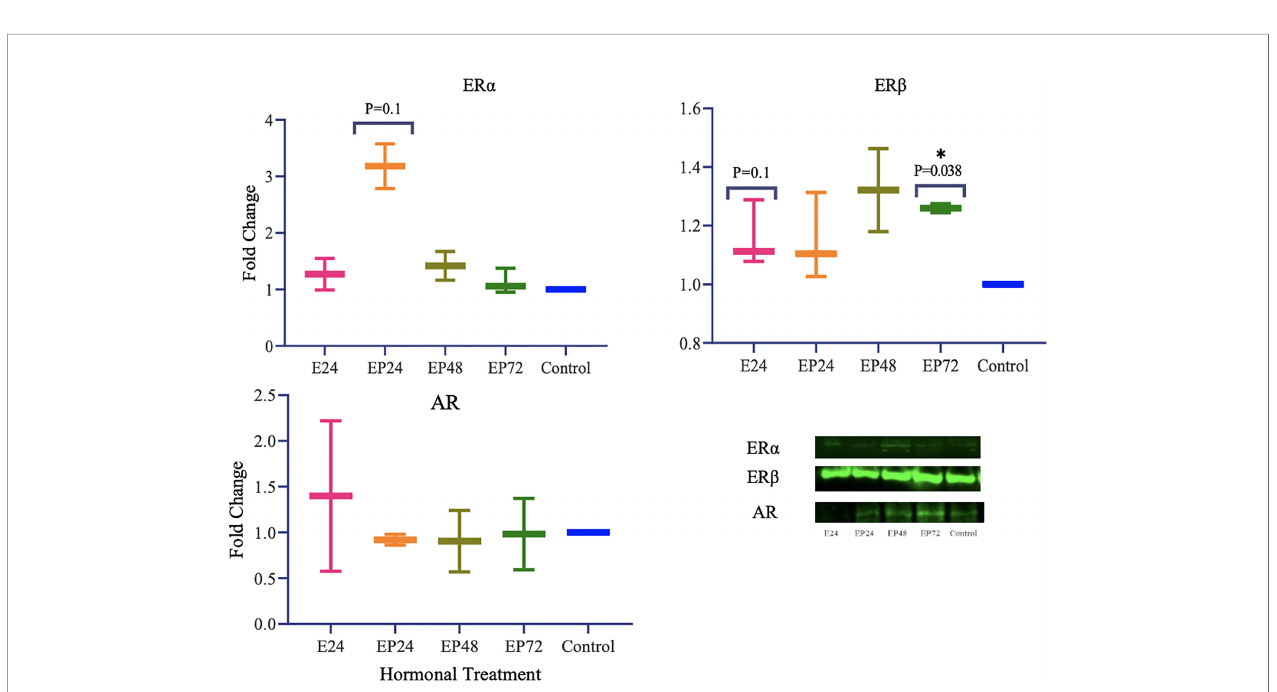
FIGURE 6 | Steroid hormone protein expression in response to different steroid hormone treatments in RL95-2 cells. A representative blot image for the particular weight band is shown next to the graph. The y-axis shows the fold change of protein levels following different treatments compared to control and x-axis shows the different treatment groups. E24 = 24h Estrogen; EP24, EP48 and EP72 = both Estrogen + Progesterone for 24, 48 and 72h. Data are presented as mean ± SEM, *p < 0.05, P ≤ 0.1 is considered as approaching signi fi cance. The experimental setup included three independent sets of cell culture experiments (n = 3) with three technical replicates for each